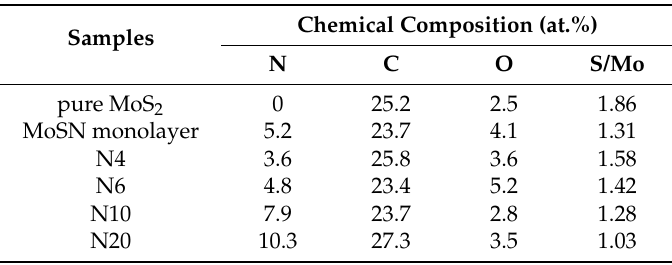
Table 1. The chemical composition of pure MoS 2 film, MoSN monolayer and MoS 2 /MoSN multilayer films characterization by